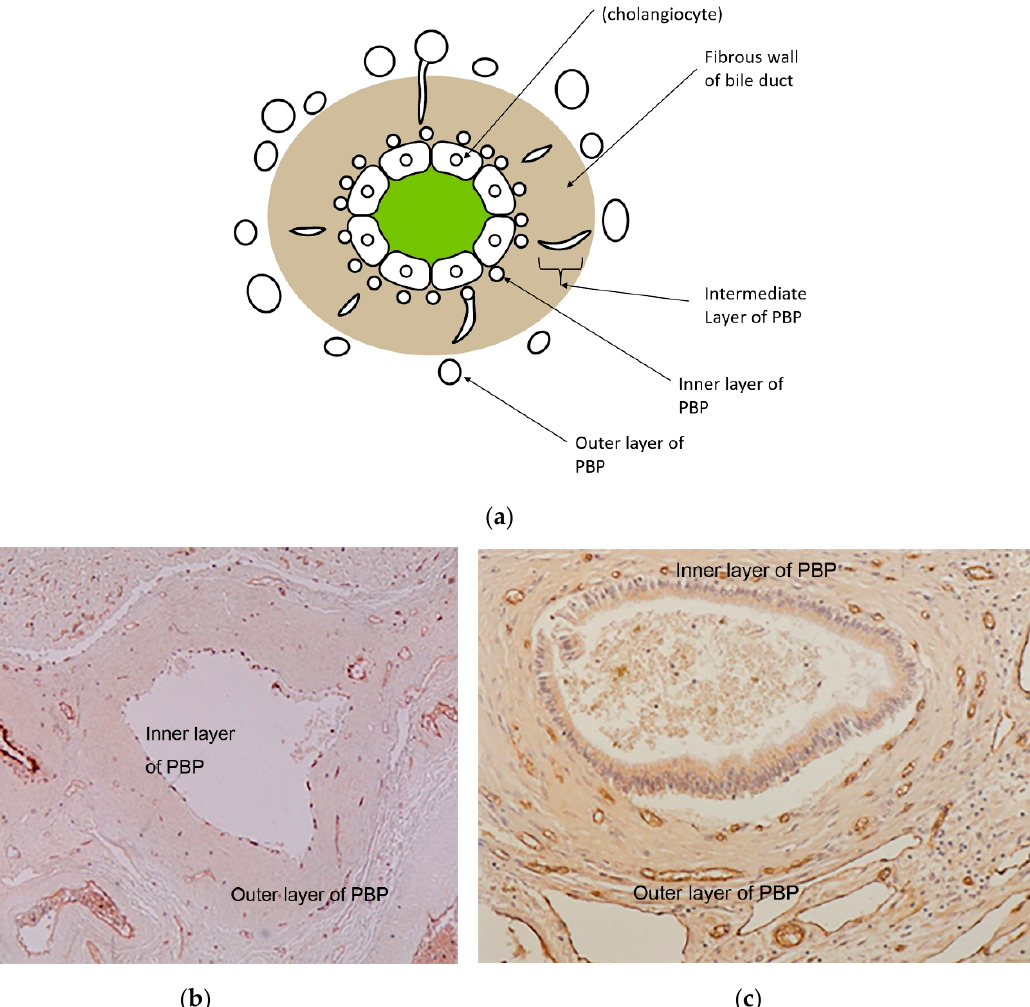
Figure 3. Schematic diagram and histopathologic image of PBP. ( a ) Schematic diagram of PBP. In the normal liver, the PBP around the large intrahepatic bile duct shows a three-layer pattern, i.e., the inner, the outer, and the intermediate layer. The inner layer of the PBP is observed just beneath the basement membrane of the bile duct epithelium, and the outer layer is present in the periductal tissue and is composed of arteries, veins, and capillaries. The intermediate layer vessels are in the duct walls and are presumed to connect the inner and the outer layer. ( b , c ) On photomicrography of the PBP in the normal liver ( b ), the inner, outer, and intermediate layer vessels of the PBP have narrow lumen and are arranged in an orderly fashion. In contrast, the PBP in the cirrhotic liver has dilated lumen and is arranged irregularly ( c ), which represents increase in collateral flow by portal hypertension.